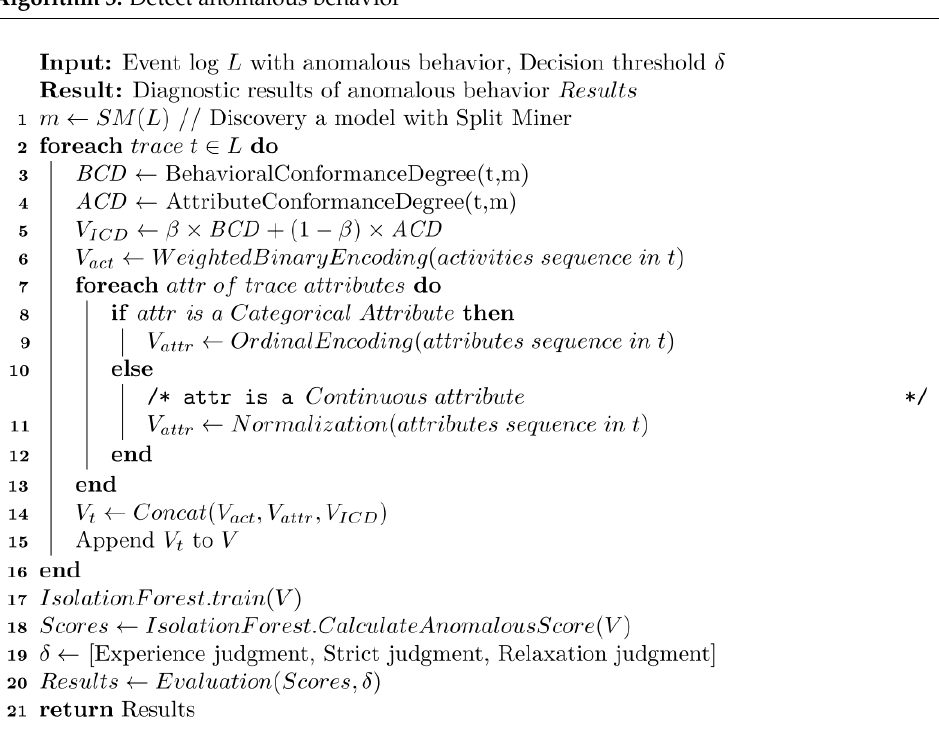
Algorithm 3: Detect anomalous